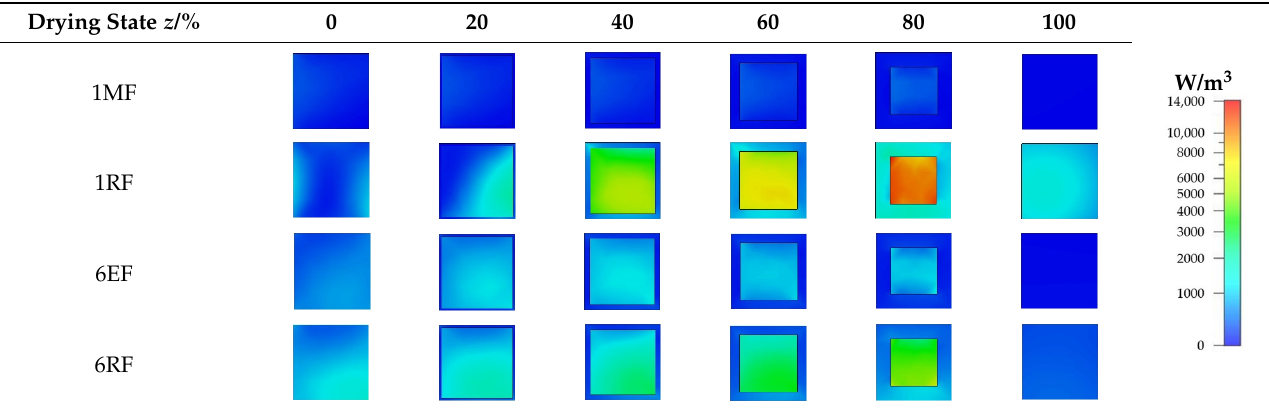
Table 2. Patterns of the volume ‐ specific power absorption from the electromagnetic simulations in an exemplary cuboid of tylose gel (top left in Figure 1a) in dependence on drying state and control concept at half height of the cuboid. At the drying states 20%, 40%, 60%, and 80%, the sample consists of a frozen core and a dried outer layer, while the drying state 0% is a completely frozen cuboid and the drying state 100%, respectively, fully dried.